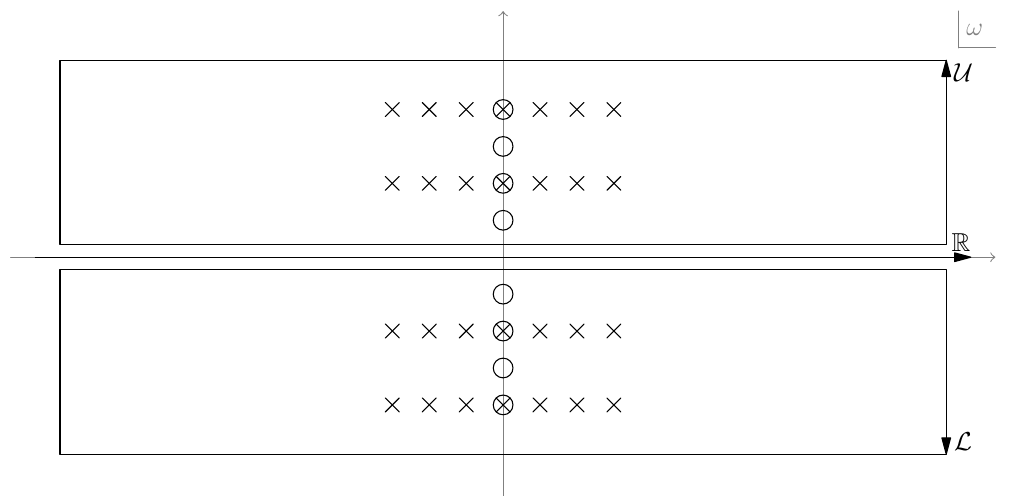
Figure 4. The contours U , L , R in the complex ω -plane. The crosses in the upper (resp. lower) half plane are the poles of f + (resp. f − ); each vertical line and its reflection across the y -axis corresponds to the poles of f ± at fixed k . The circles are the poles of A ij (i.e. the poles of n ( ω ) ), which we discuss in section